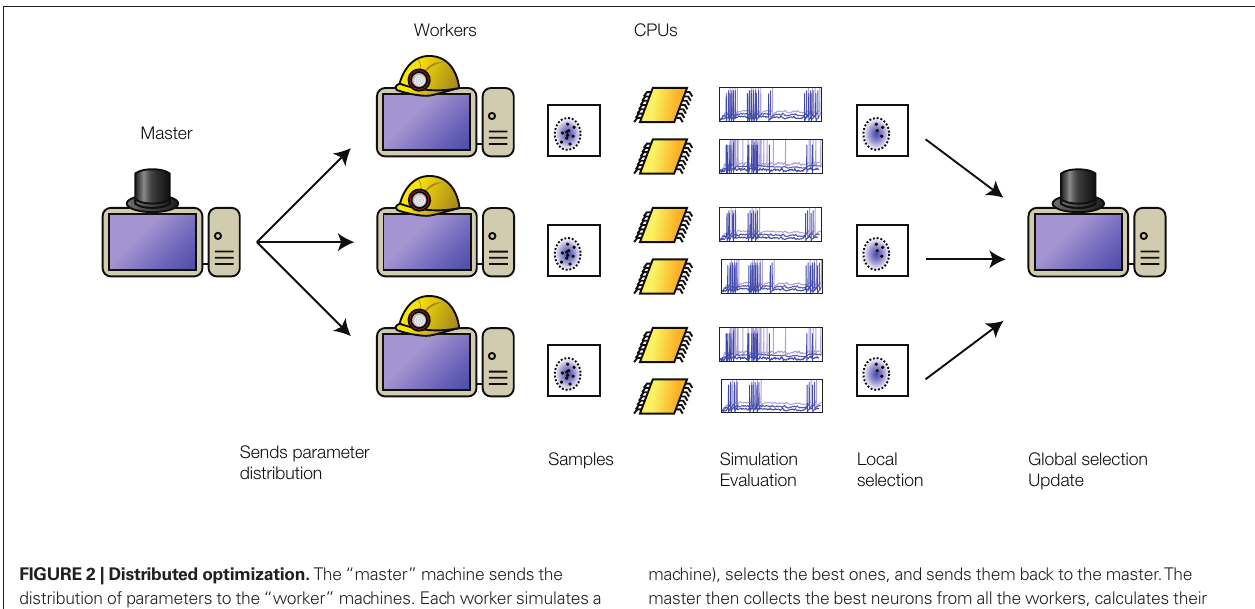
Figure 2 | Distributed optimization. The “master” machine sends the distribution of parameters to the “worker” machines. Each worker simulates a population of neurons with parameters drawn from this distribution, evaluates their prediction performance (possibly making use of multiple CPUs on each